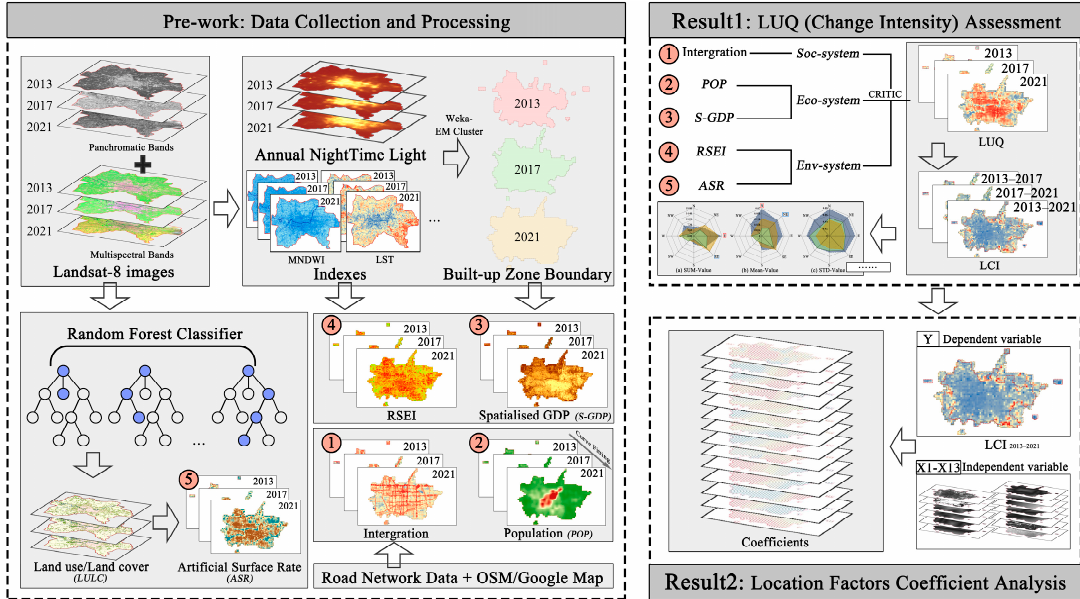
Figure 1. Flowchart: data preparation, LUQ assessment and MGWR calculation.